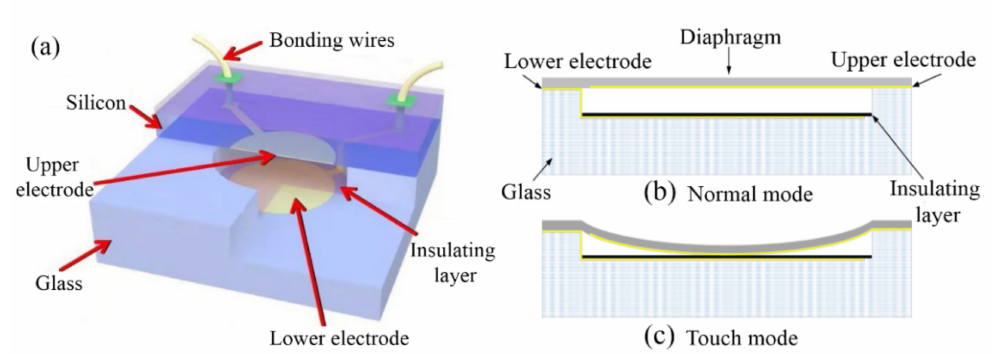
Figure 1. Schematic 3D structure of a self-packaged CPS ( a ) and its working principle in ( b ) Normal mode and ( c ) touch